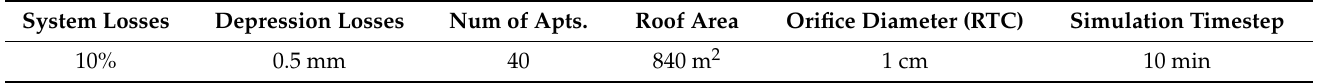
Table 1. Parameters of the simulated RWH system.